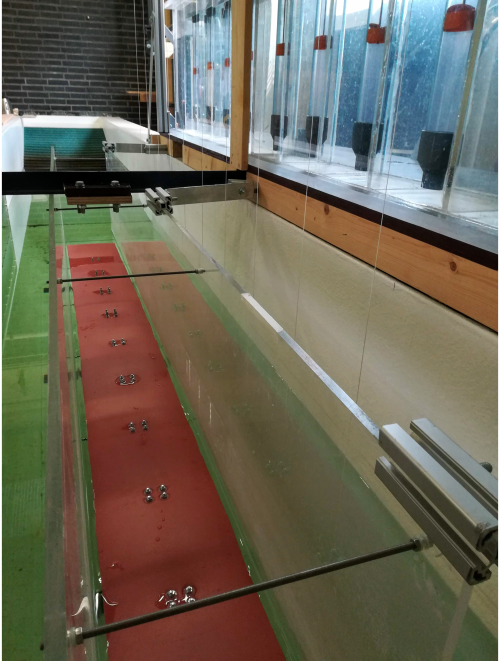
Figure 7. The floater blanket, made by a two-layer red silicone sheet, inside the wave tank. The absorbing beach is visible at the end of the